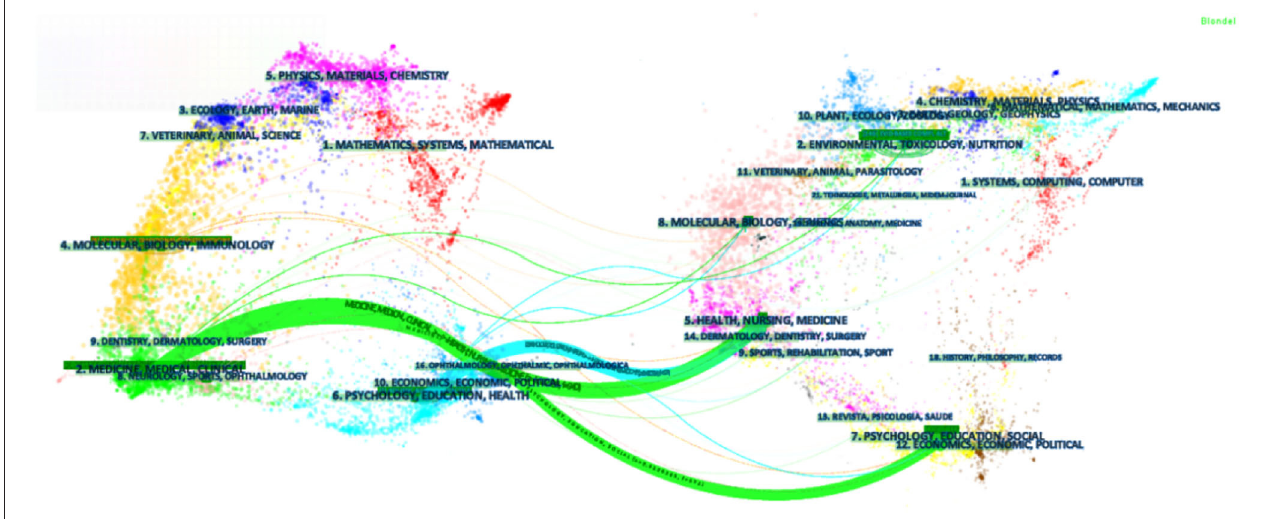
FIGURE 4 | The dual-map overlay of journals related to PE research. [The Dual-map Overlay of Journals Related to the treatment of Insomnia by TCM Nursing Techniques research. There were three citation paths. The top green path, articles published in medicine/medical/clinical journals mostly cited journals in health/nursing/medicine area; the bottom green path, articles published in medicine/medical/clinical journals partially cited journals in psychology/education/social area. The blue path, articles published in psychology/education/health journals partially cited journals in health/nursing/medicine area. (Color figure